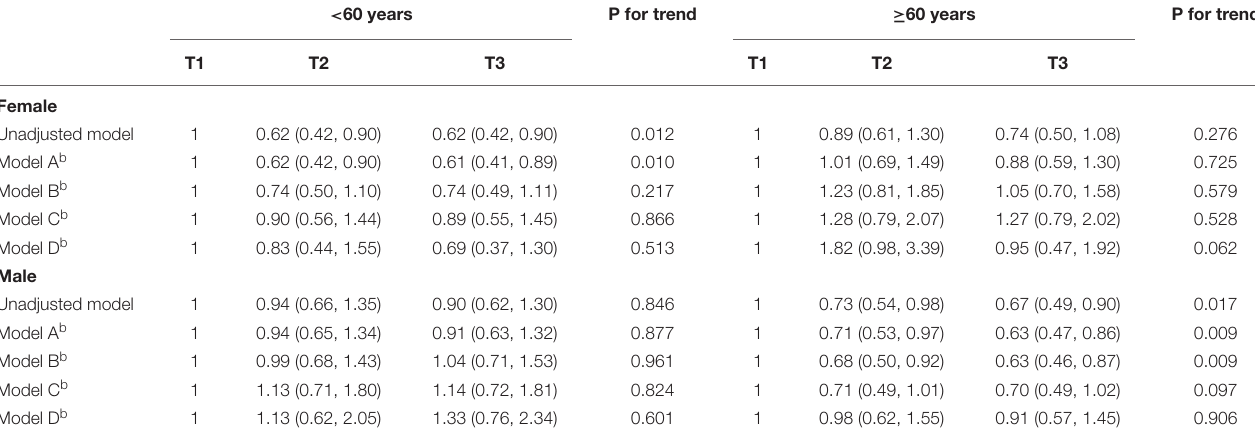
TABLE 4 | Association between fat mass and all-cause mortality using Cox proportional hazard regression. < 60 years P for trend ≥ 60 years P for